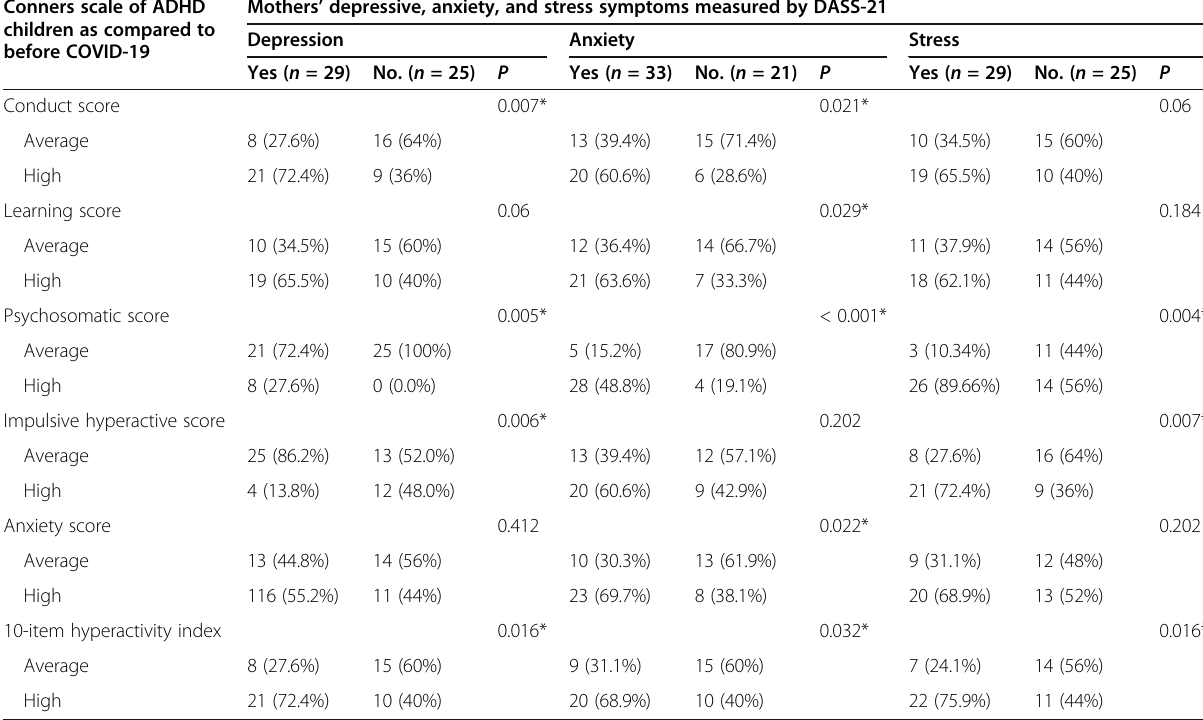
Table 6 Association between the behavioral problem of ADHD children measured by Conners ’ Parent Rating Scale Revised-short version (CPRS-48) and depression, anxiety, and stress symptoms of the mothers Conners scale of ADHD Mothers ’ depressive, anxiety, and stress symptoms measured by children as compared to before COVID-19